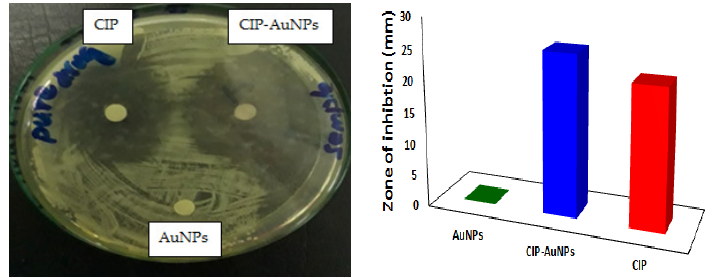
Figure 6. The zone of inhibition (ZI) displayed by CIP, AuNPs, and CIP-AuNPs for E. faecalis . Figure 6. The zones of inhibition (ZI) displayed by CIP, AuNPs, and CIP-AuNPs for E. faecalis